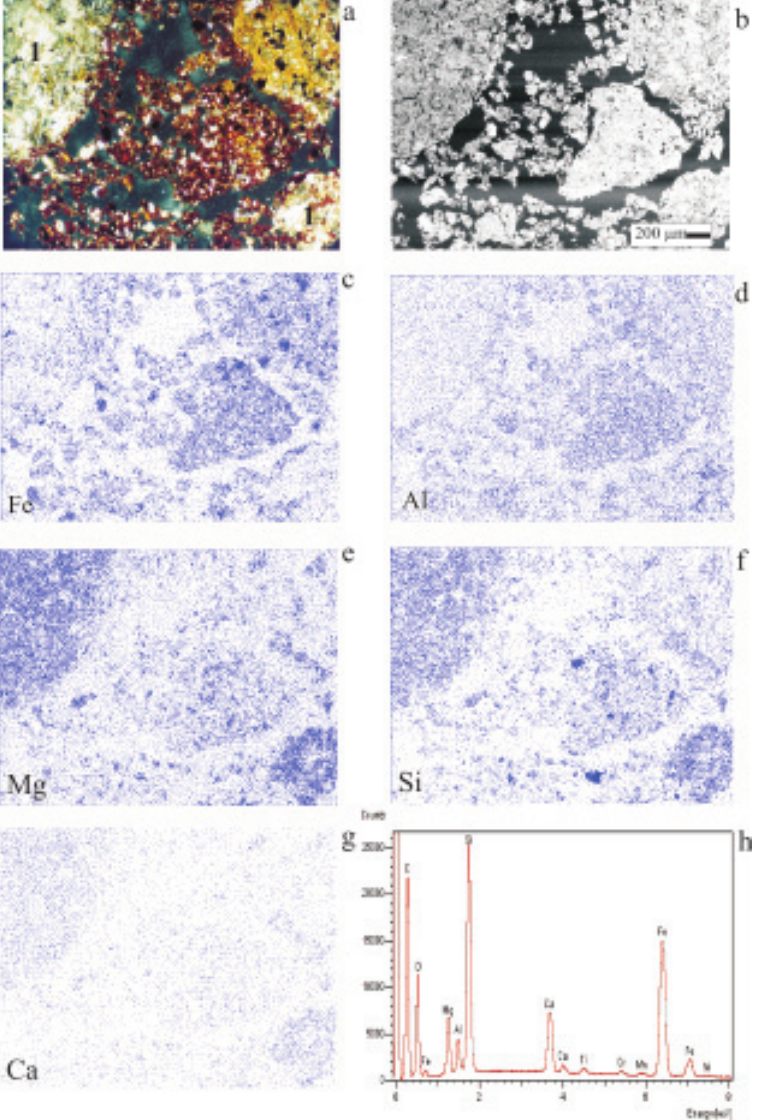
Figura 6. Análise química de uma seção delgada do horizonte Bi do perifl-1. (a): Fotomicrografia sob luz polarizada cruzada, ilustrando três fases distintas de alteração: rocha (1), alteromorfo (2) e agregado de solo ou ped (3). (b): Imagem de elétrons retroespalhados do mesmo campo da figura 8a. (c, d, e, f, g): imagens do mapeamento por EDRX feito para os elementos Fe, Al, Mg, Si, Ca respectivamente. (h): Espectro EDRX total do